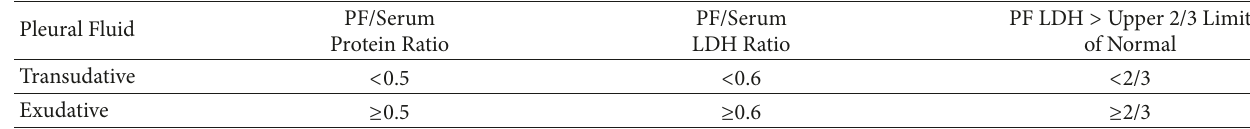
Figure 1: Initial chest x-ray demonstrating pleural effusion and abnormal cardiac silhouette. Table 1: Light’s